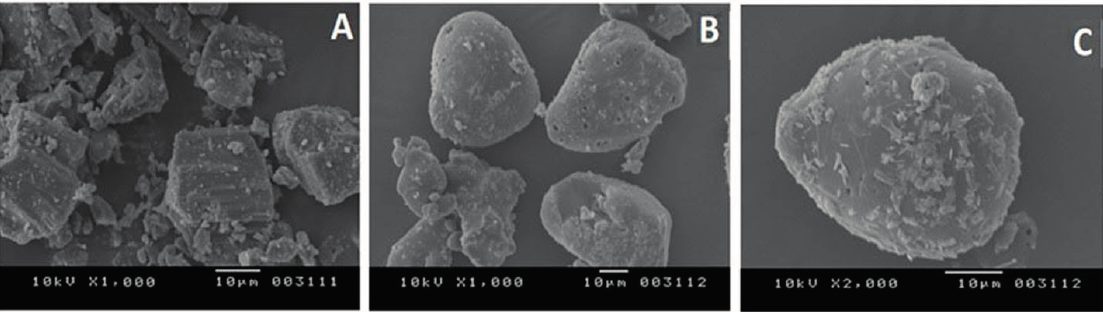
Figure 4. Scanning Electron Micrograph of ( A ) CMN at 1000×; ( B ) MSC CMN at 1000×; and ( C ) MSC CMN at